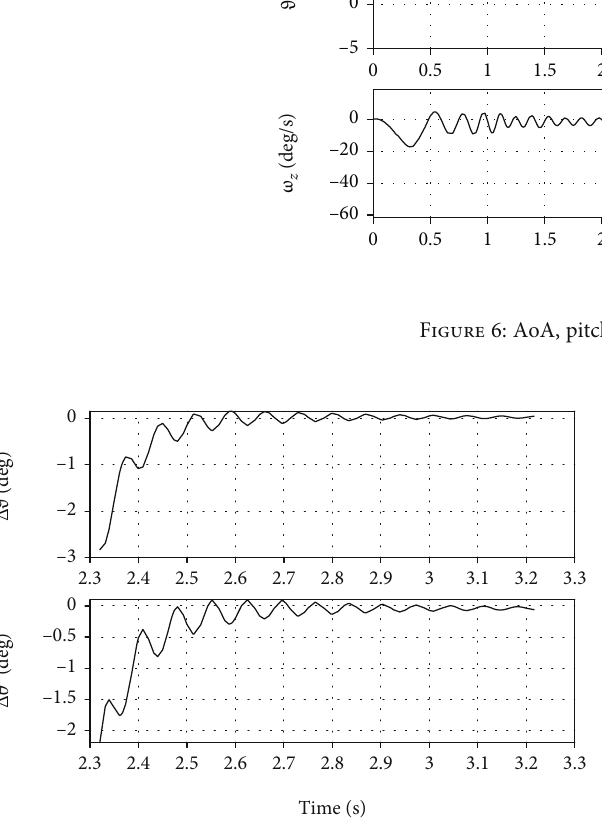
Figure 7: Deviation curve of pitch angle and inclination